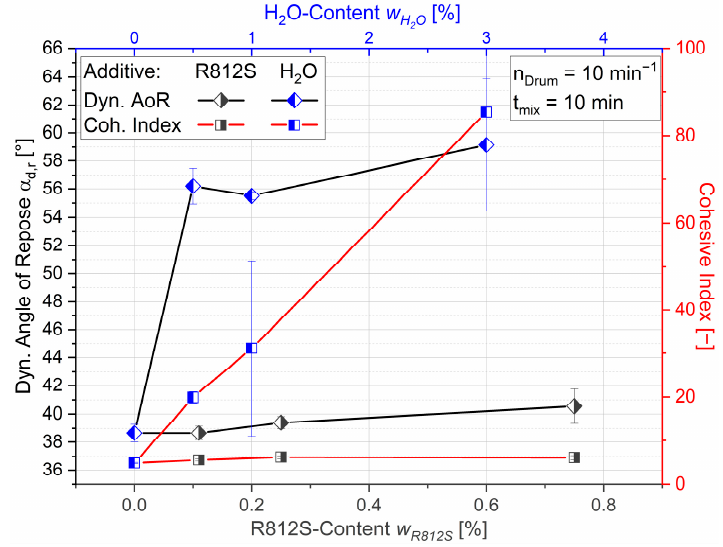
Figure 1. Dynamic angle of repose (left) and cohesive index (right) as a function of the H 2 O content (top) and R812S content (bottom).